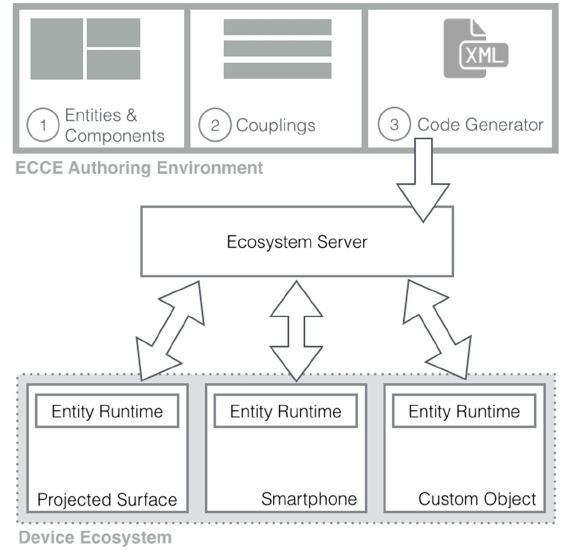
Figure 2. The architecture for creating a device ecosystem with ECCE.